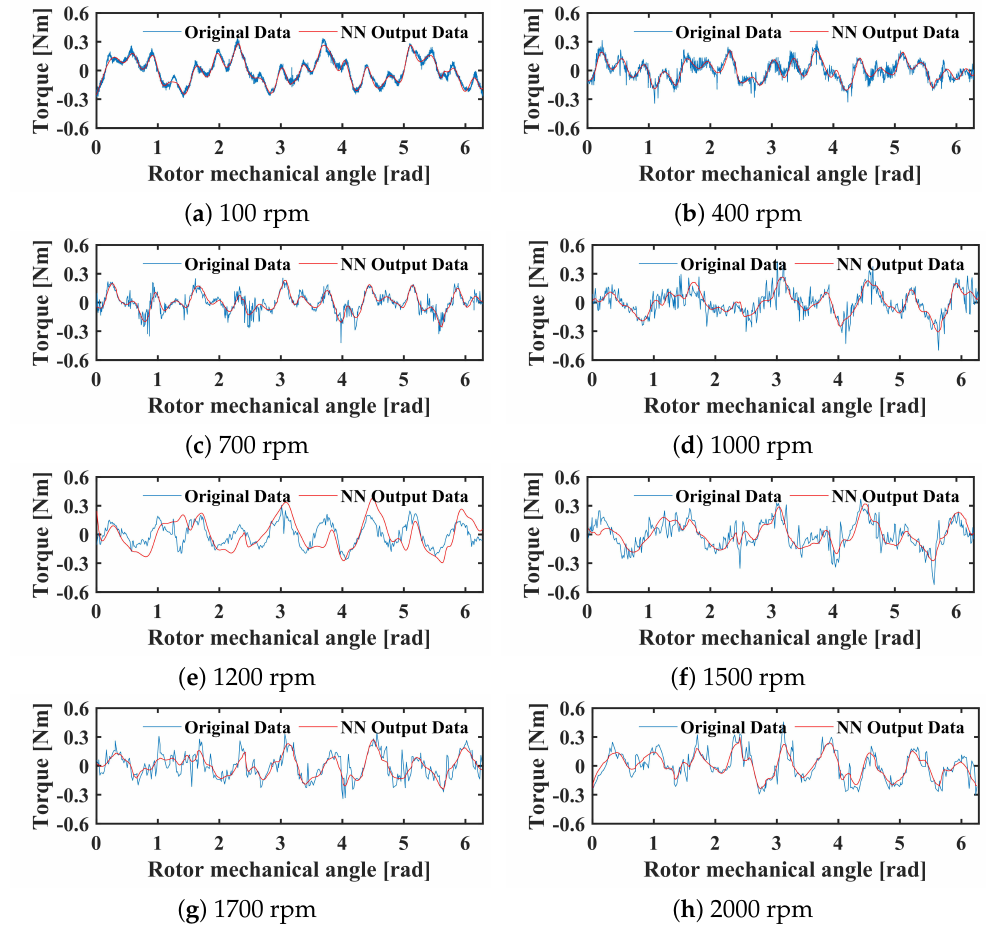
Figure 9. The actual torque ripple waveform and output of the trained NN at the speed of: ( a ) 100 rpm,